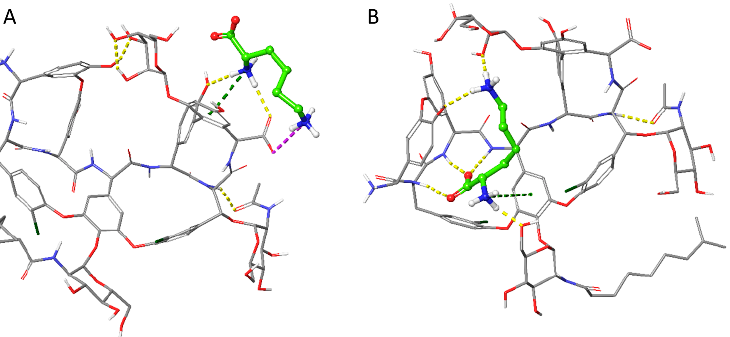
Figure 4. Best interaction frames of the molecular dynamics run of the teicoplanin with the Lys, in grey and green carbon atoms, respectively. The hydrogen bond, π -cation, and charge–charge interactions are shown in yellow, green, and magenta dashed lines, respectively. The panel ( A ) displays the frame where the Lys engages multiple interactions with the carboxylic moiety of the selector, while panel ( B ) shows the interactions engaged in the teicoplanin basket.